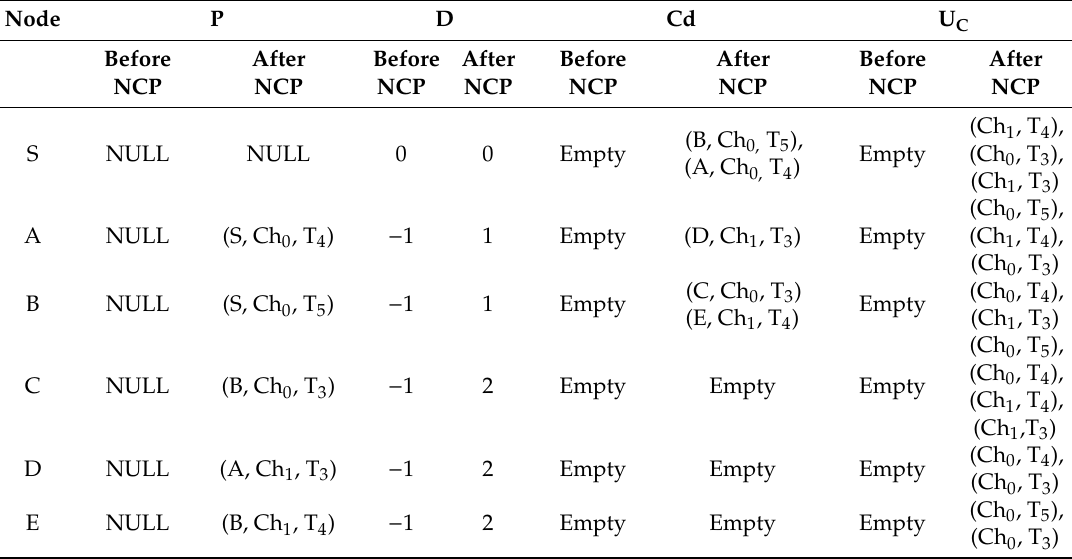
Table 1. Information maintained by the nodes after the network construction period.